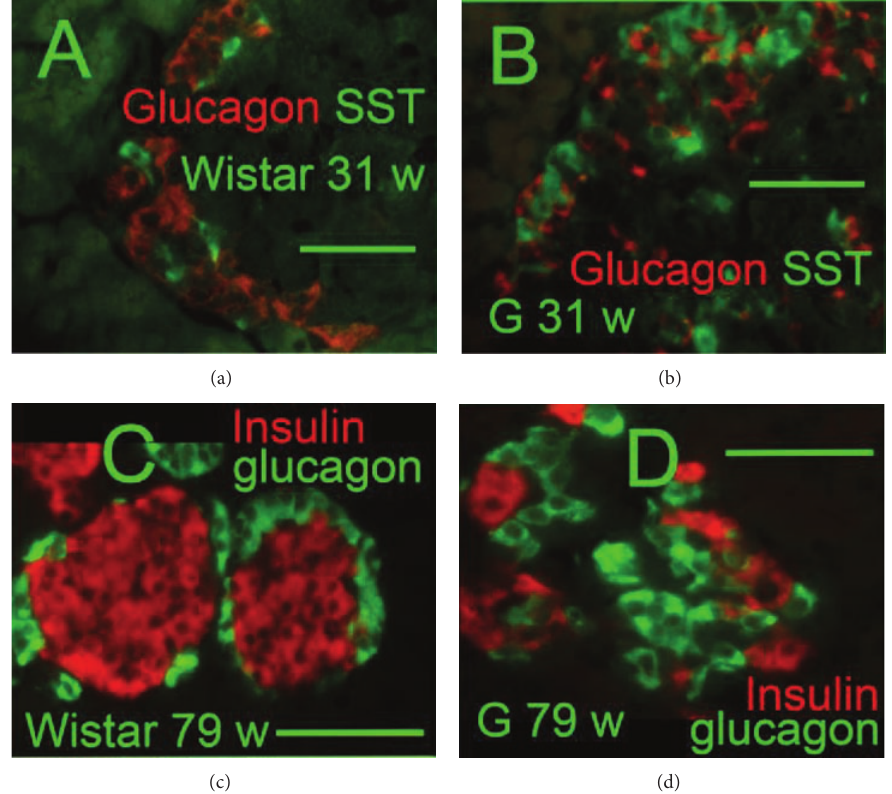
Figure 4: Glucagon, somatostatin, and insulin immunohistochemical pattern of pancreatic islets (a), (b) glucagon : red and SST : green ; (c), (d) insulin : red , glucagon : green , and “w”: weeks. Overlay images of pancreatic islets of 31-week-old Wistar (a) and Goto-Kakizaki (b) rats “G” and 79-week-old Wistar (c) and Goto-Kakizaki (d) rats “G.” Original magnification is 400x in (a), (b) and 600x in (c), (d); scale bars 20 𝜇